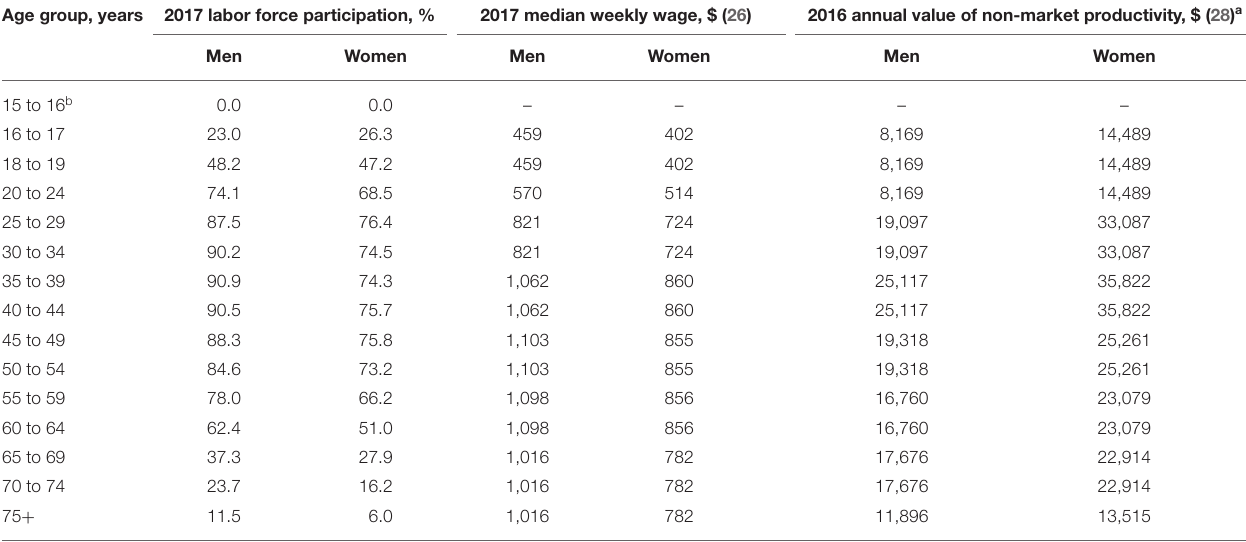
TABLE 2 | Input: age- and sex-specific labor force participation, earnings, and non-wage productivity in the United States. Age group, years 2017 labor force participation,